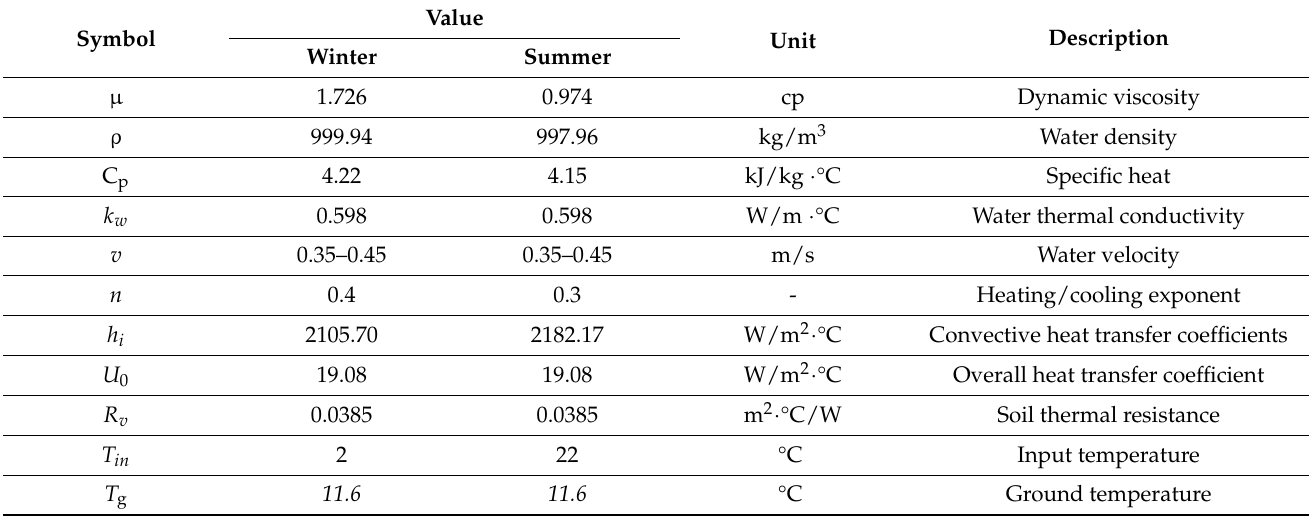
Table 3. Parameters of the ground heat exchanger